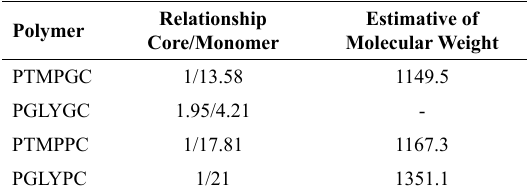
Table 2. Estimative of molecular weights of polymers by NMR Inverse gated